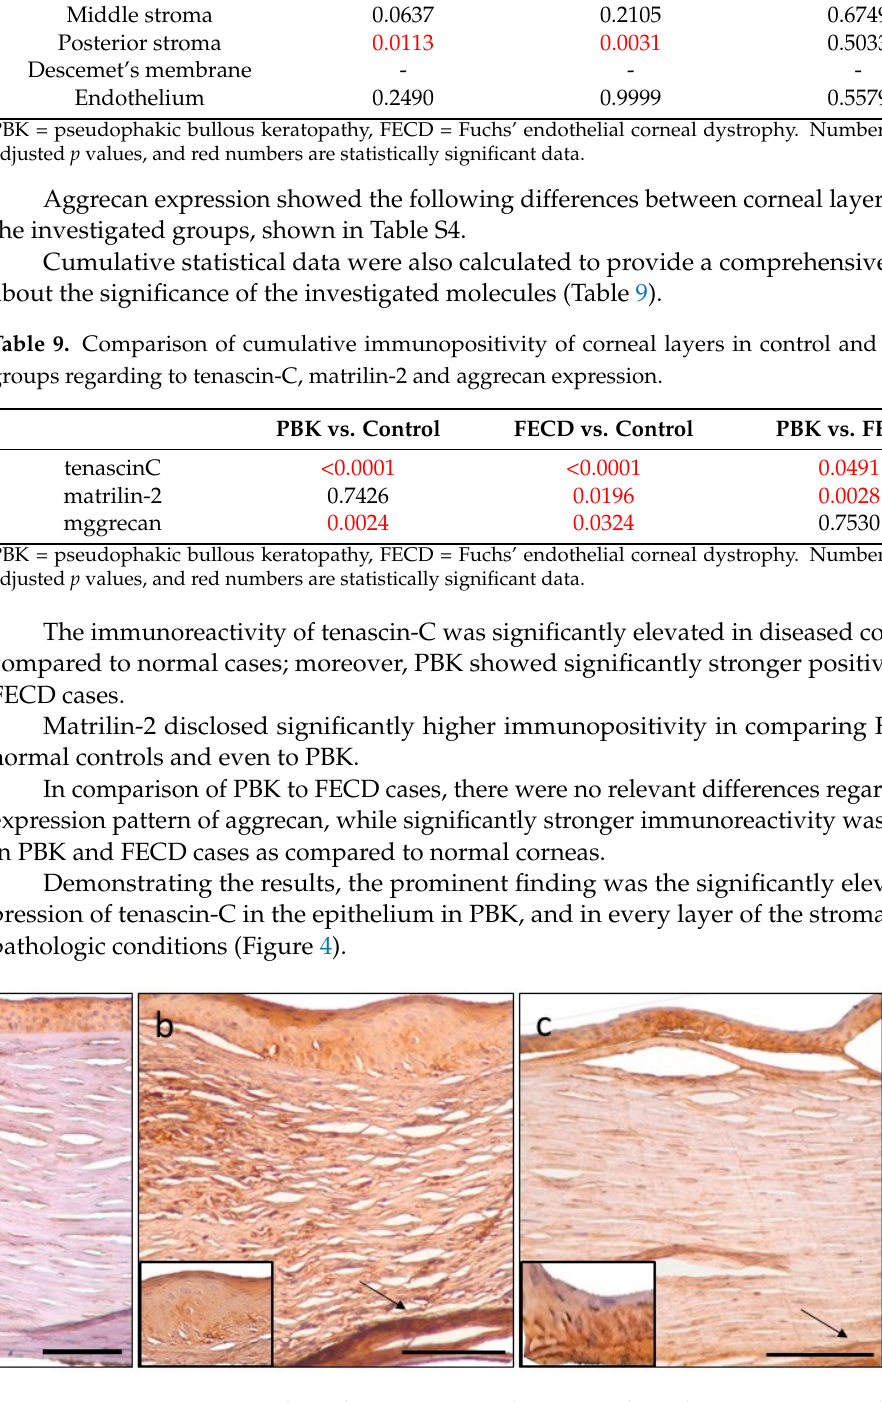
Figure 5. Matrilin-2 immunohistochemistry. Control cornea with minimal immunopositivity in the epithelium and endothelium and unstained stroma ( a ). Moderate epithelial immuno-expression in PBK and the rest of the tissue is unstained ( b ). FECD specimen also disclosed moderate epithelial staining and minimal stromal positivity is present in the posterior area (asterisk) ( c ). Epithelial signal intensity (insets). Scale bar refers to 100 µm. Figure 6. Aggrecan immunohistochemistry. Control section with minimal immunopositivity in the epithelium ( a ). Mild-to-moderate epithelial and stromal immunopositivity in PBK ( b ) and FECD ( c ) is present. Posterior stroma disclosed more intense labelling (arrow). Epithelial signal intensity (insets). Scale bar indicates 100 µm.